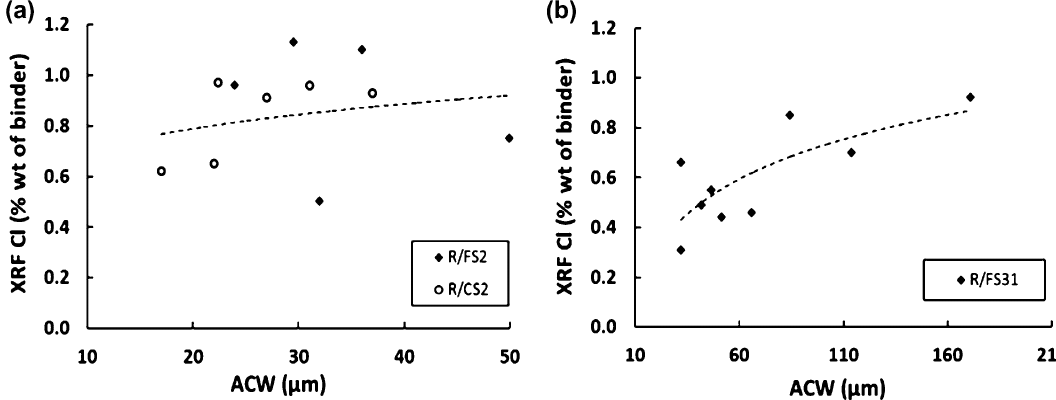
Fig. 19 Relationship between total chlorides (Cl) determined by XRF and average crack widths (ACW) in the R/SHCC